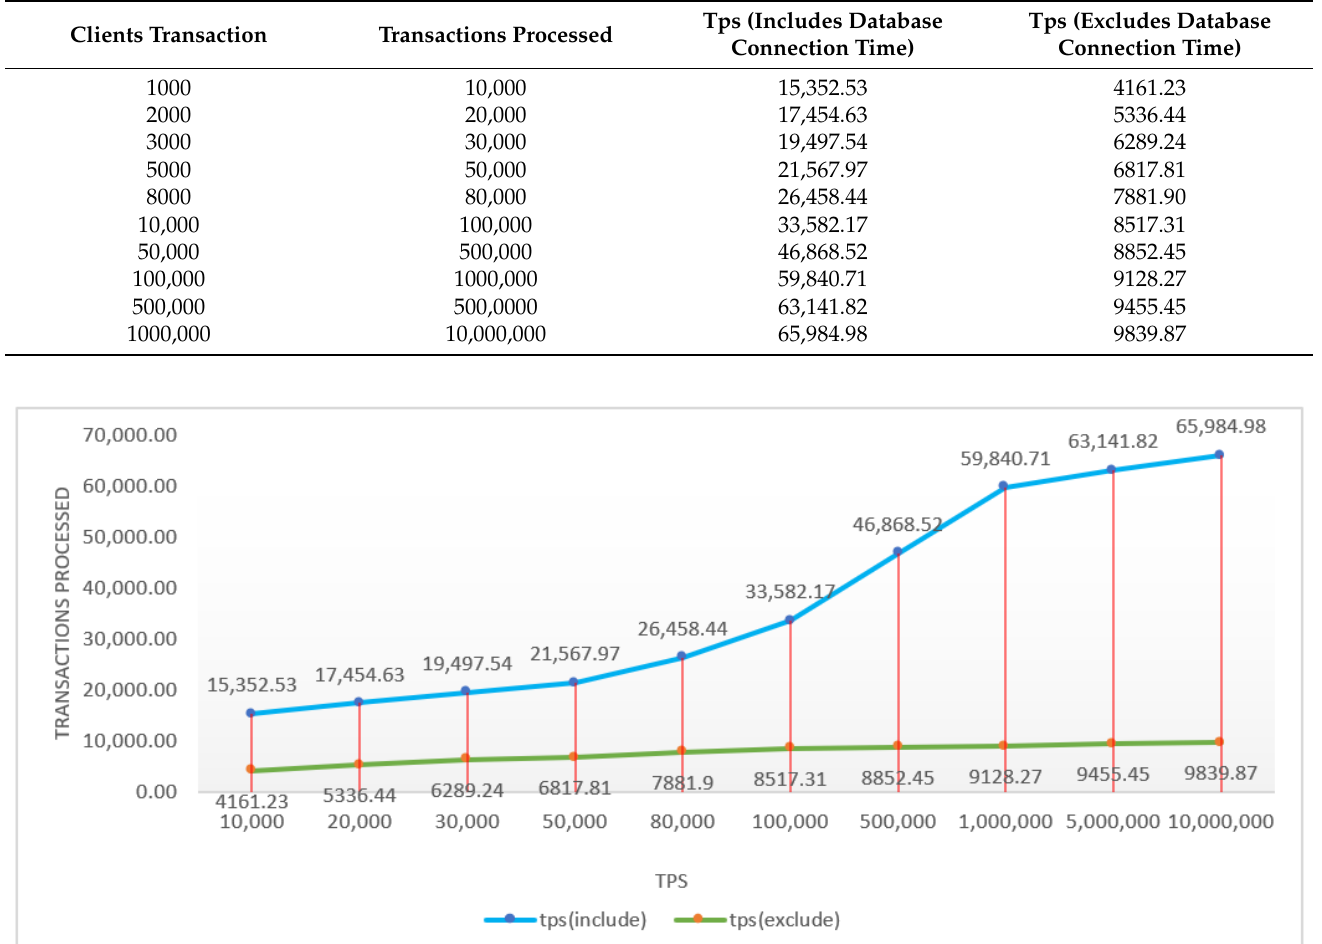
Table 3. Intensive testing of the database depends on the processes initiated by the users in relation to the connections.